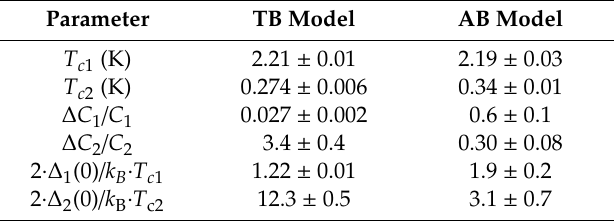
Table 5. Deduced parameters for for Nb / BiSbTeSe 2 -nanoribbon / Nb junction (Sample 1 [56]) at V g = 45 V from fit to two-band Titov and Beenakker (TB) [53] and Ambegaokar and Barato ff (AB) [7,8] models.